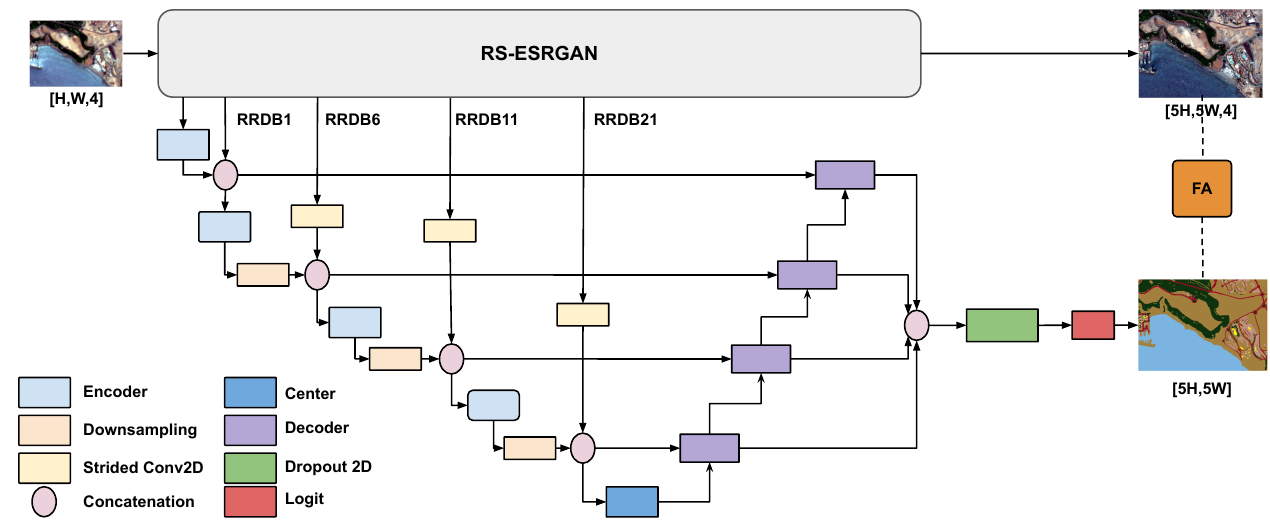
Figure 6. SEG-ESRGAN model to produce a super-resolution image and enhanced segmentation maps of remote sensing images.